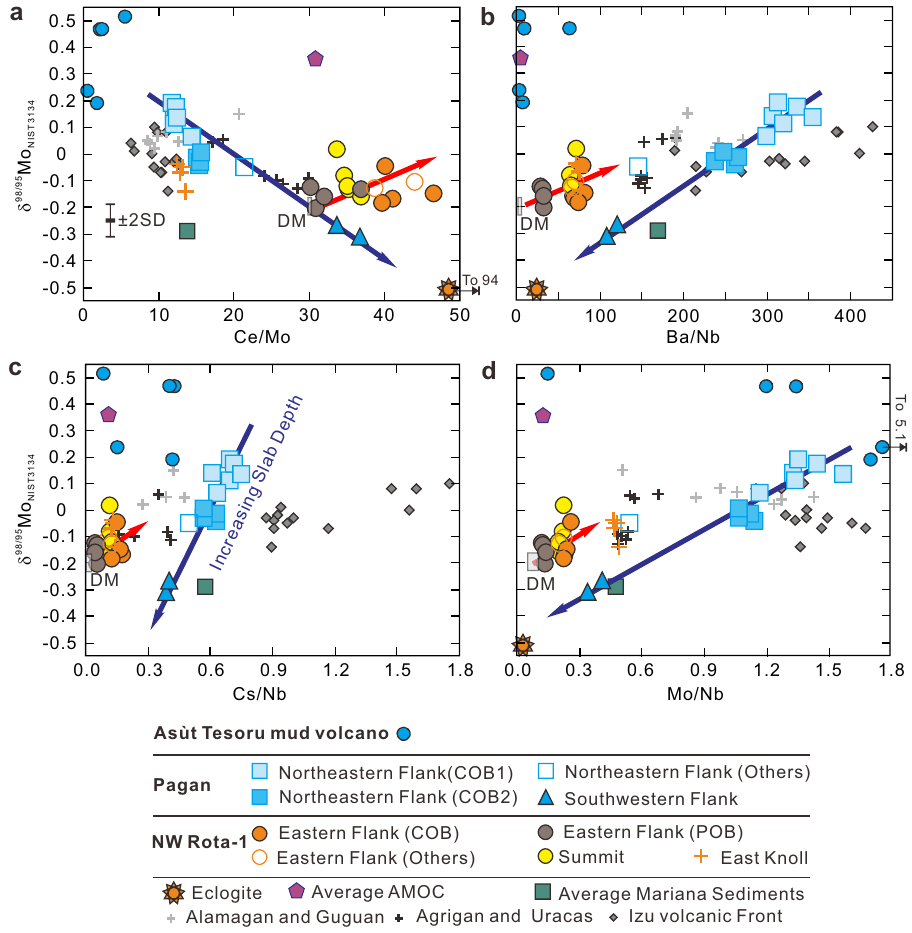
Fig. 3 Mo isotope and trace element systematics of serpentinite mud and volcanic rock samples. Plots of δ 98/95 Mo vs. a Ce/Mo, b Ba/Nb, c Cs/Nb, and d Mo/Nb for the Asùt Tesoru serpentinite mud samples and Pagan and NW Rota-1 volcanic rock samples unaffected by amphibole fractional crystallization. The Izu arc 33 , other Mariana volcanic front volcanoes 8 , average Mariana sediments 6,8 , 801 C AMOC Super Composite 8,72 and average blueschist and eclogite data from the Raspas Complex and Cabo Ortegal Complex 32 are also plotted for comparison. The ranges for depleted mantle (DM) are estimated according to the studies of Bezard et al. 34 , Gale et al. 44 , Workman and Hart 73 , and Salters and Stracke 43 . COB clinopyroxene-olivine basalt, POB plagioclase-olivine basalt, AMOC altered ma fi c oceanic crust, SD standard deviation. The blue arrows show compositions of magmas formed above increasing slab